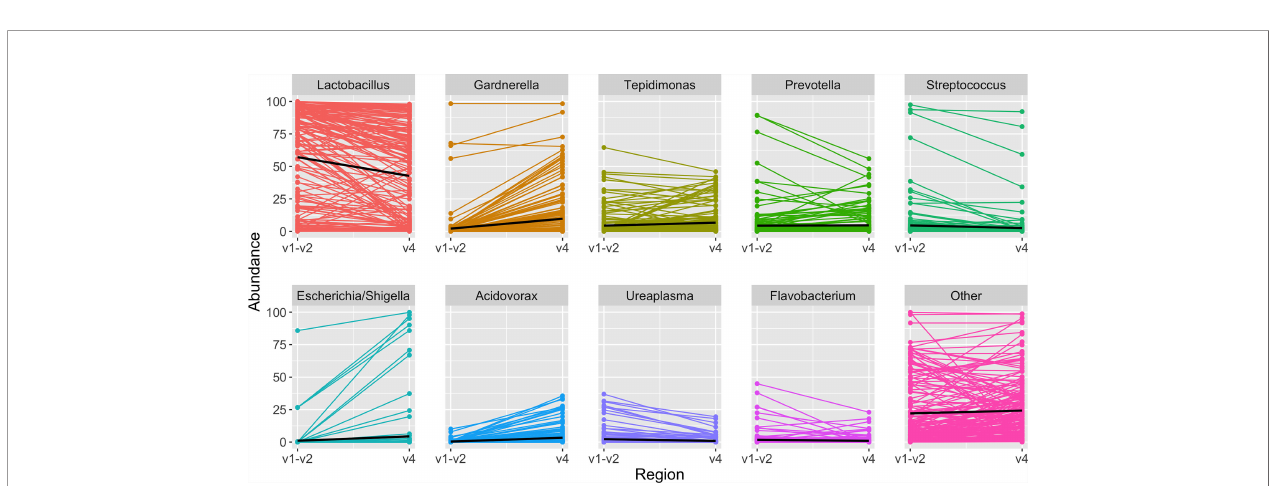
FIGURE 6 | Highest abundance genera among paired samples. Each panel depicts the relative abundance of one genus. On the left is the relative abundance from the V1-V2 amplicon, connected by a line to the right, which shows the relative abundance in the same sample when identi fi ed from the V4 amplicon. In each panel the black line summarizes the median abundances across all paired samples. When comparing results from the same sample sequenced with two different amplicons, Lactobacillus was identi fi ed in slightly higher abundance with the V1-V2 amplicon, while other genera including Gardnerella, Tepidomonas, Escherichia/Shigella , and Acidovorax were identi fi ed in slightly higher abundance with the V4